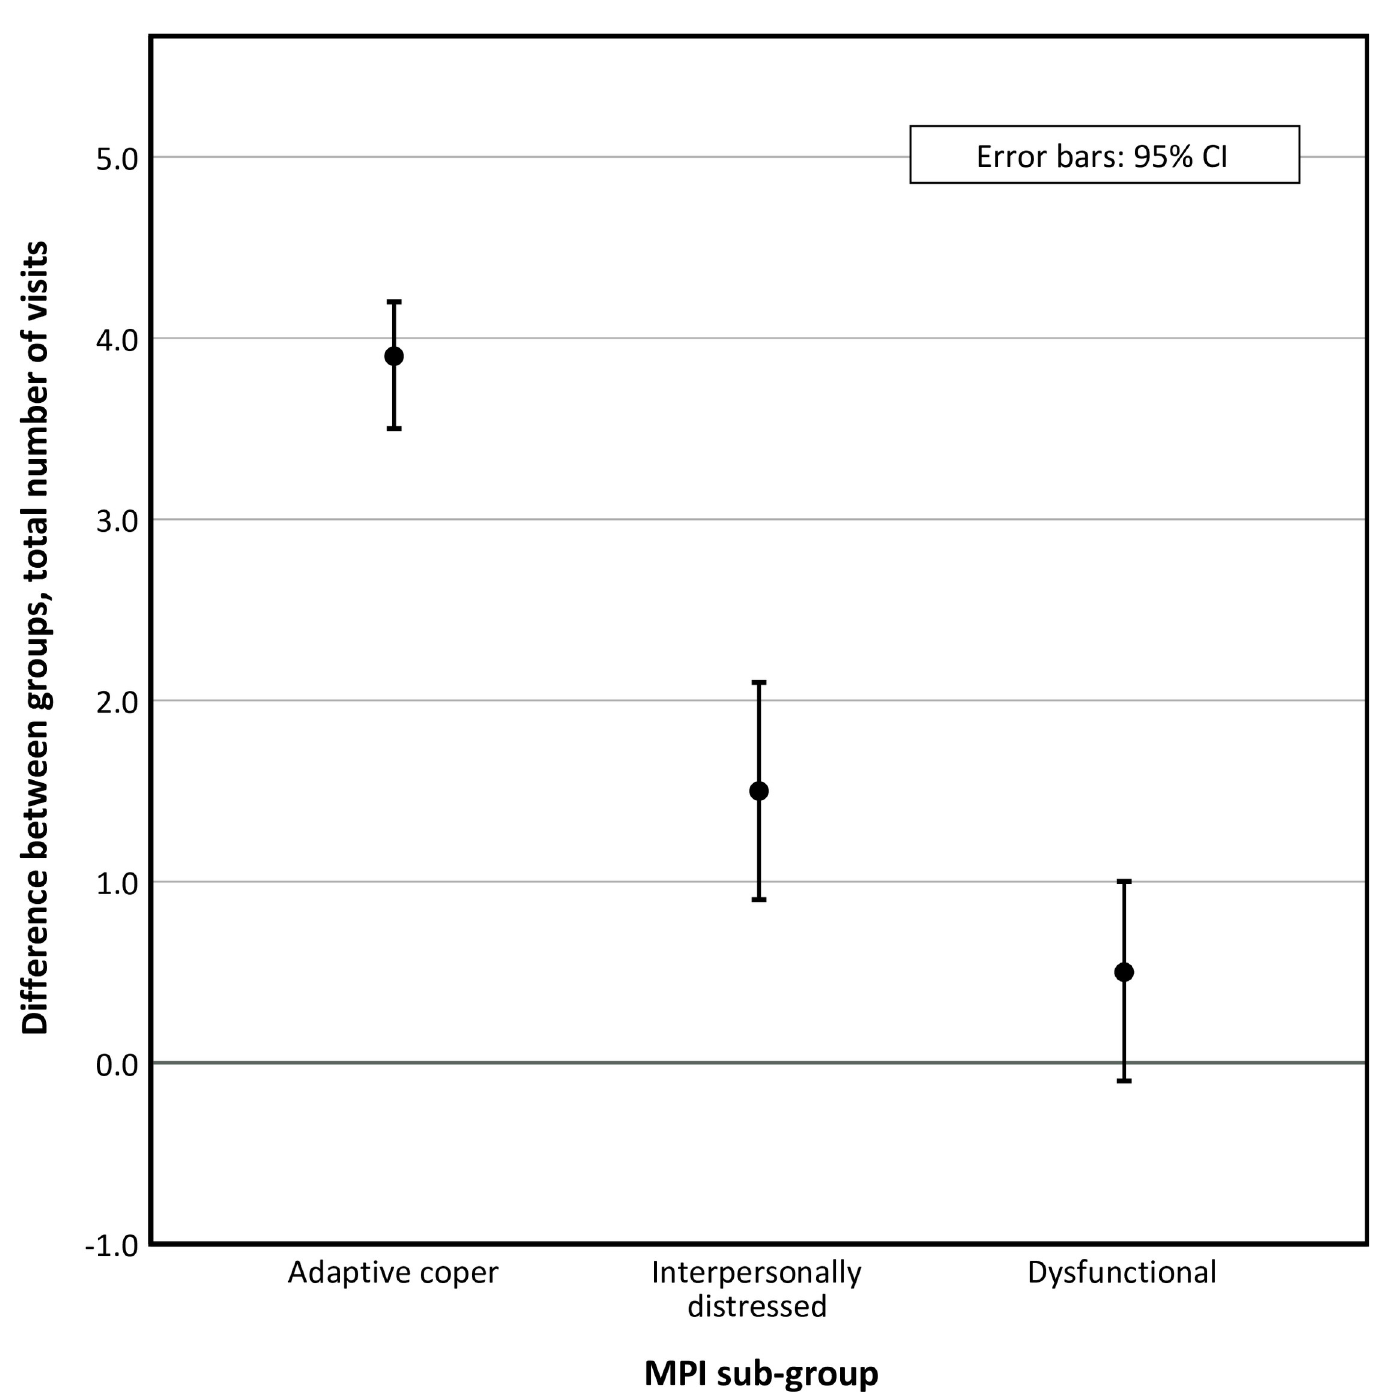
Fig 8. Total number of visits during study period, group differences (MC-control). MC ; maintenance care; CI , confidence interval; LBP , low back pain; MPI , West Haven-Yale multidimensional pain